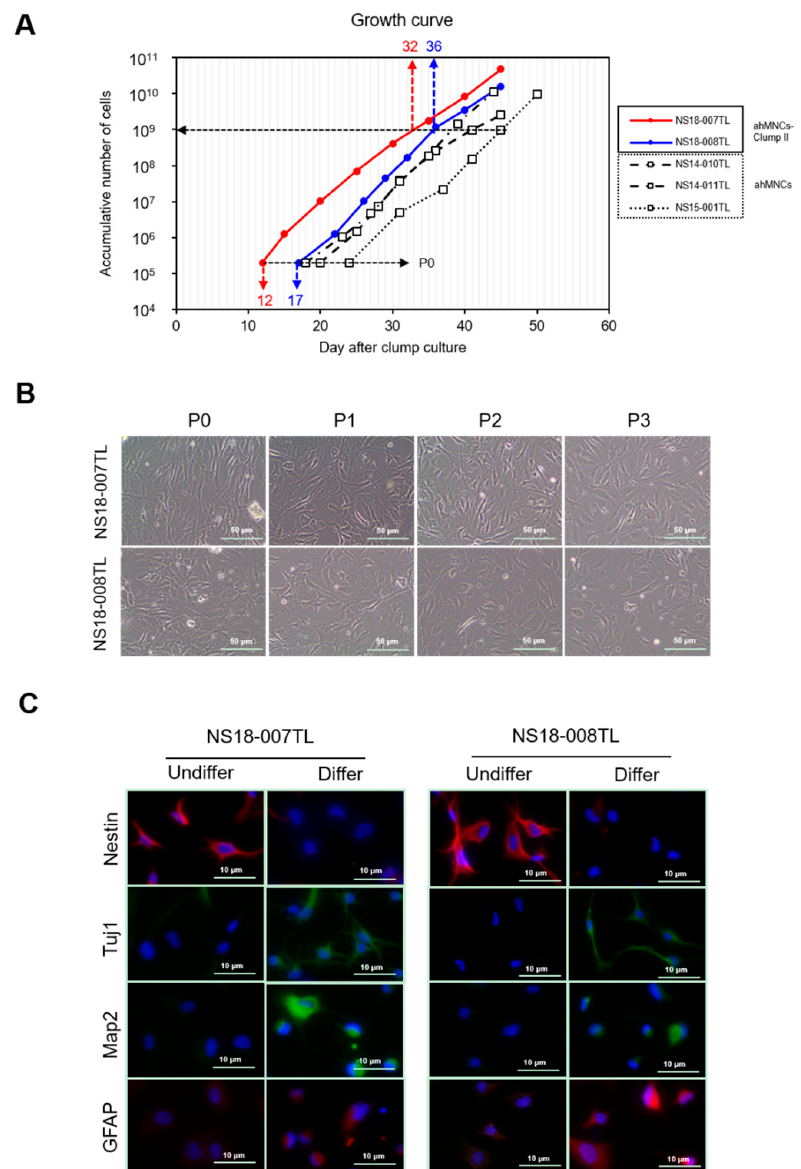
Figure 3 . In vitro proliferation and differentiation of ahMNCs-Clump II. ( A ) ahMNCs-Clump II were propagated in the culture condition for ahMNCs. The accumulated number of cells of ahMNCs-Clump II (NS18-007TL and 008TL) in comparison with ahMNCs established using previous culture methods (NS14-010TL, NS14-011TL, and NS15-001TL). Days to 1 × 10 9 cells are indicated. ( B ) Morphologies of ahMNCs-Clump II under expansion processes are illustrated until third in vitro passage (P3). Scale bar = 50 µm. ( C ) After in vitro differentiation, immunofluorescence was applied to ahMNCs-Clump II. Nestin for NSCs, MAP2 and Tuj1 for neurons, and GFAP for astrocytes. Undiffer = before in vitro differentiation; Differ = after in vitro differentiation. Scale bar = 10 µm.